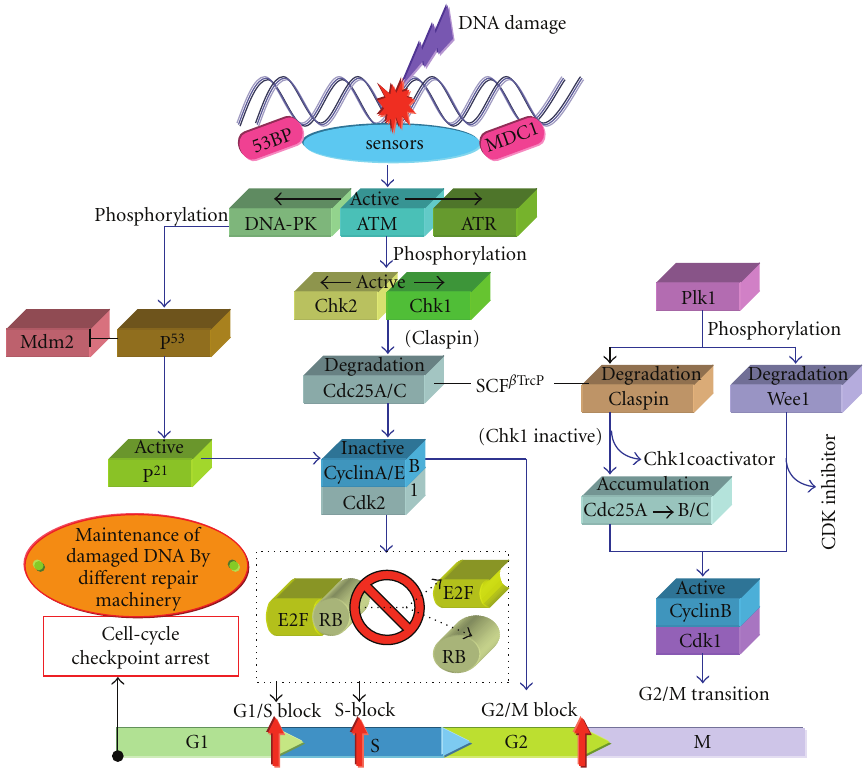
Figure 15: Schematic illustration of DNA damage-induced cell-cycle checkpoint activation (for details, see text).